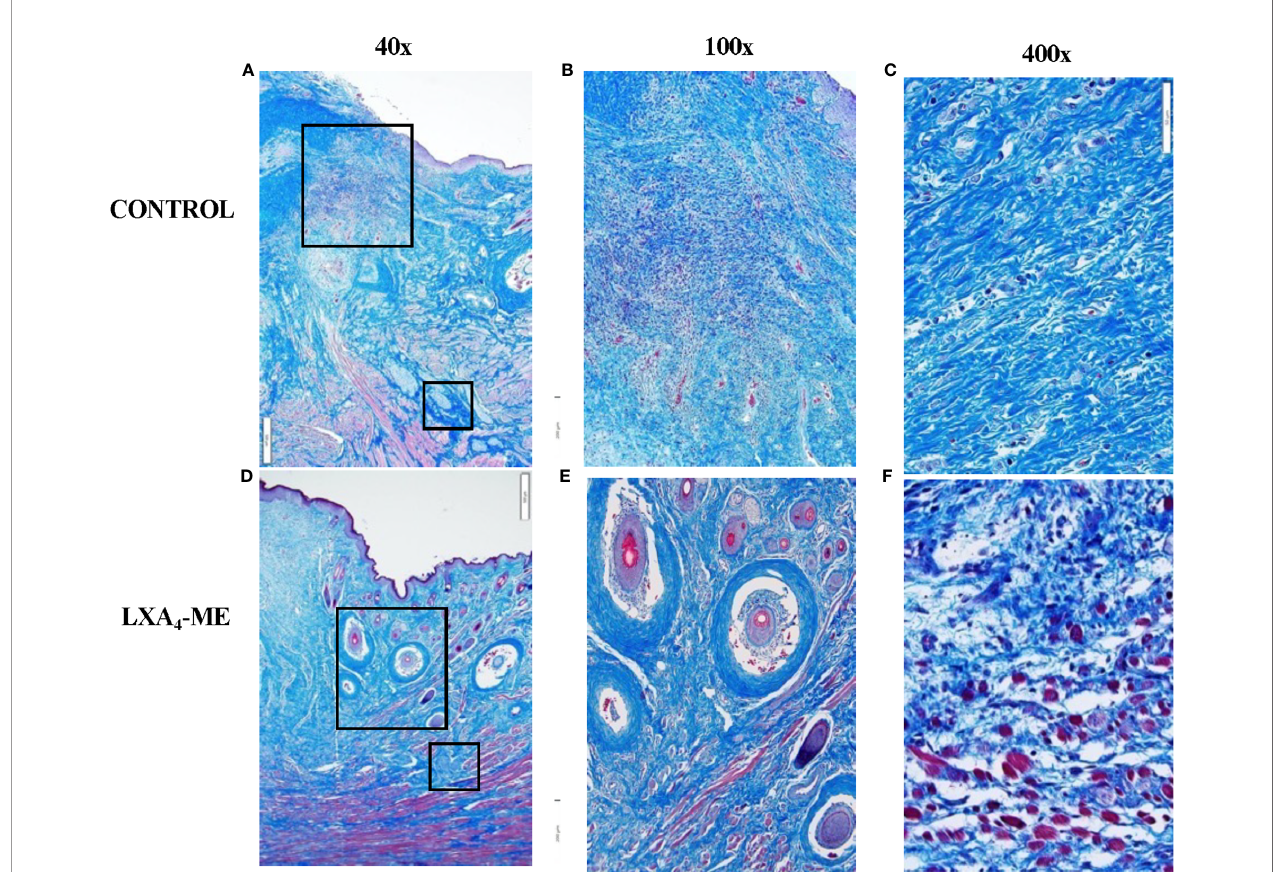
FIGURE 4 | Microscopic examination of images of representative tissue specimens stained with Masson ’ s Trichrome captured at 40x magni fi cation (A, D) . Large and small rectangular areas were captured at 100x (B, E) and 400x (C, F) , respectively. Animals treated with LXA 4 -ME after cleft lip repair showed decreased density of collagen fi bers compared to control treated with PBS. A higher number of hair follicles was observed in histological sections of animals treated with LXA 4 - ME (D, E) compared to control (A, B) , indicating wound healing closer to normal skin than scar tissue. Muscle fi bers and cells were more frequently identi fi ed within collagen fi bers in animals treated with LXA 4 -ME (D, F) , while scar tissue and dense collagen interfered with muscle regeneration in control animals (A,C) . The scale bars represent 500 um (A, D) , 200 um (B, E) and 50 um (C, F)